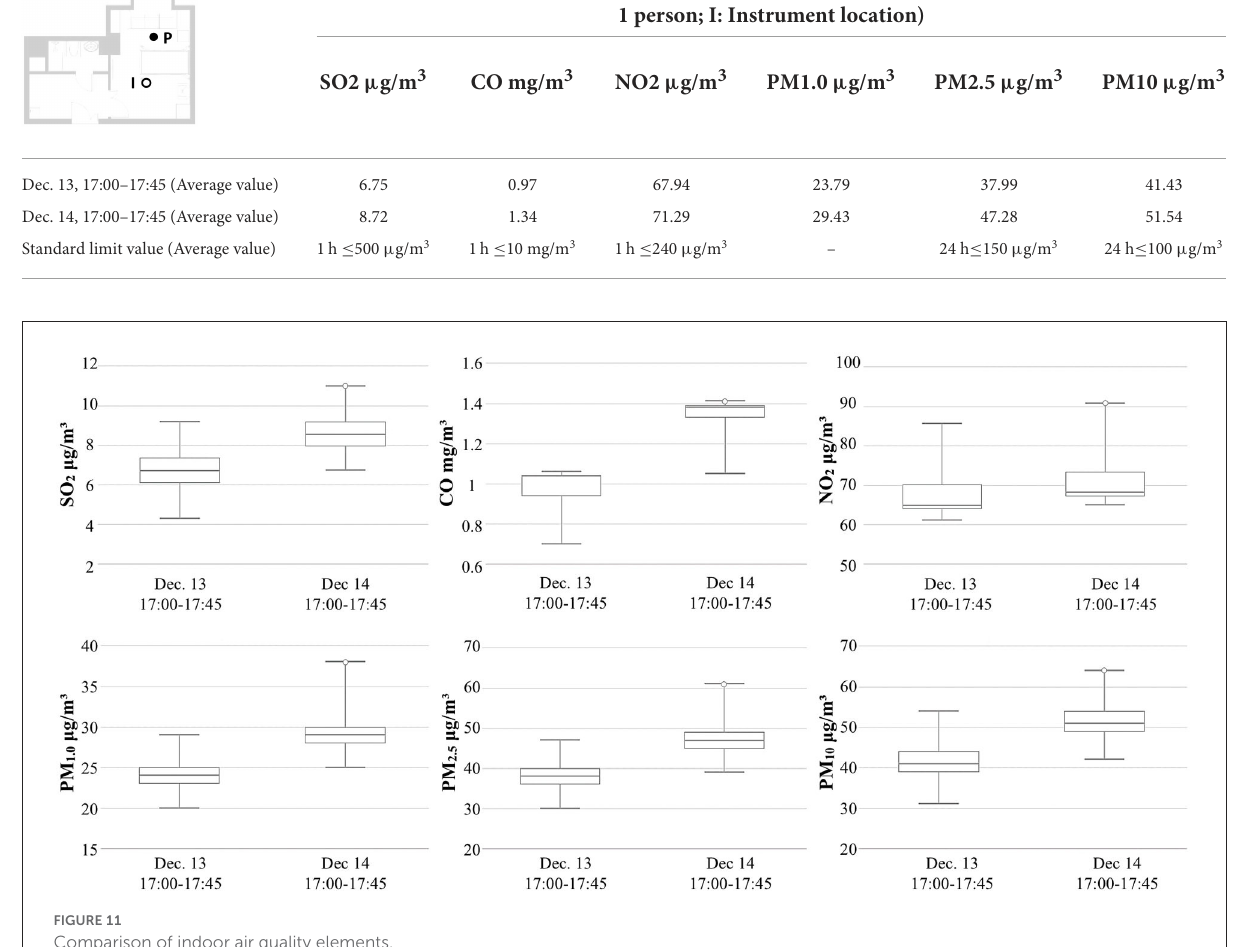
FIGURE11 Comparison of indoor air quality